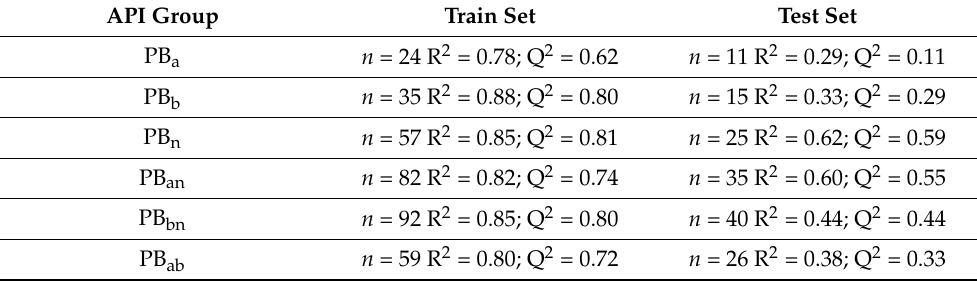
Table 5. Random forest regression results on individual drug combinations. API